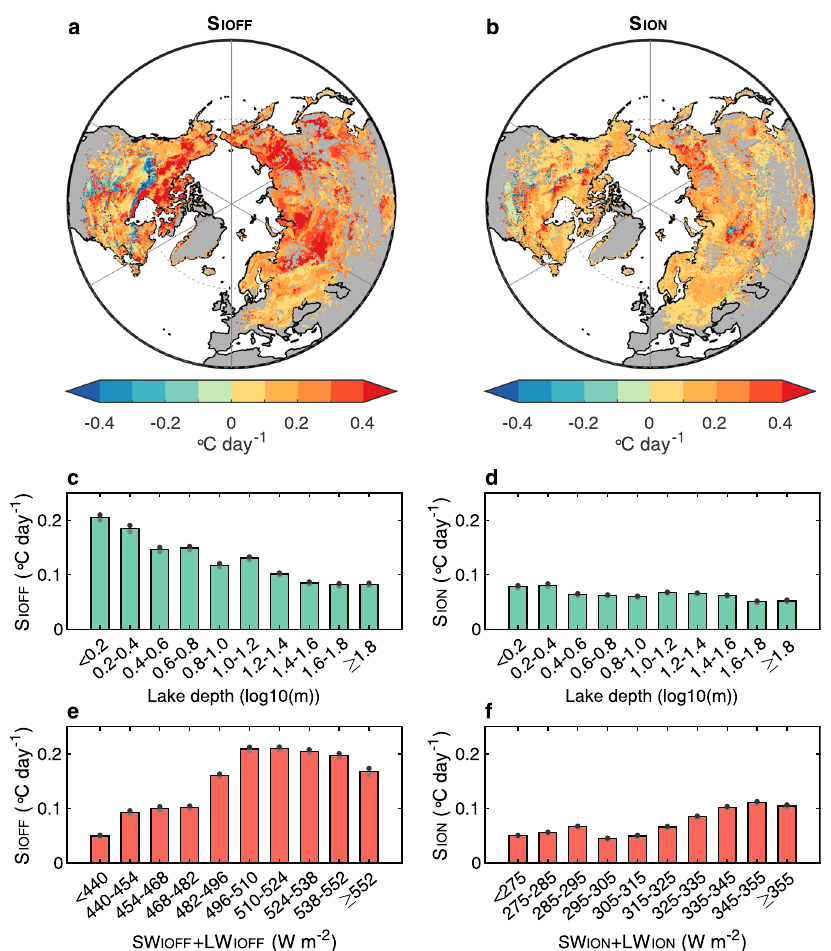
Fig.4|Sensitivityoflakesurfacetemperaturetolakeicephenology.a , b Spatial pattern of the sensitivity of lake surface temperature to changes in ice-off dates ( S IOFF ; a ) and ice-on dates ( S ION ; b ). c , d Distribution of S IOFF ( c ) and S ION ( d ) as a function of lake depth binned into 0.2×log10 m intervals. e , f Distribution of S IOF and S ION as a function of incoming radiation binned into 14 and 10Wm − 2 intervals,